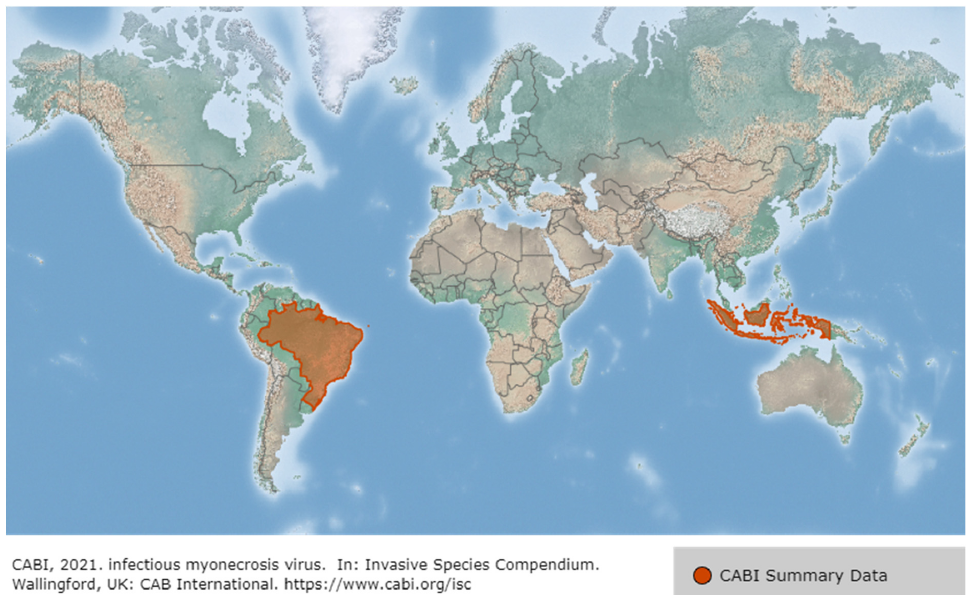
Figure 12. Distribution map showing the geographical occurrence of infectious myonecrosis virus (IMNV) (Reprinted from CABI, 2019, Infectious myonecrosis virus. In: Invasive Species Compendium. Wallingford, UK: CAB International, with permission from CABI).